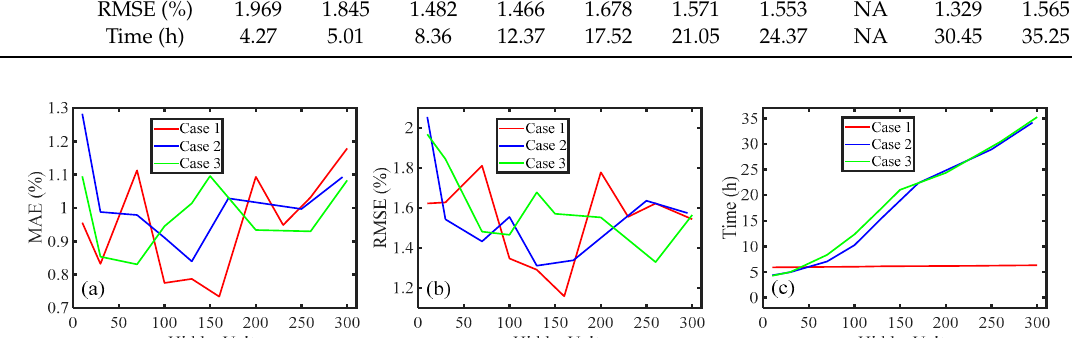
Figure 6. The evaluation index values in three cases: ( a ) Mean absolute error (MAE), ( b ) root mean square error (RMSE), ( c ) training time.